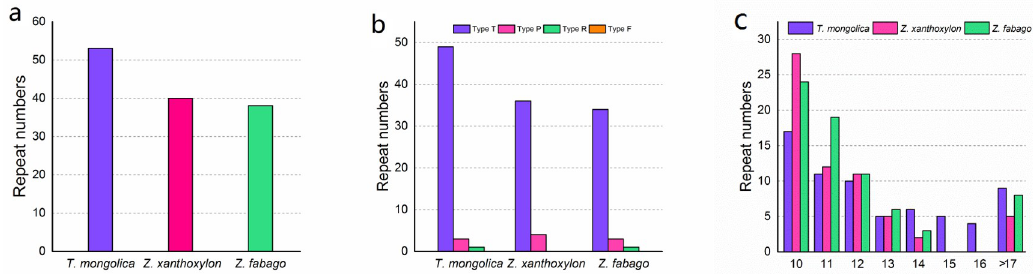
Fig 3. Long repeat sequences in chloroplast genomes of T . mongolica , Z . xanthoxylon , and Z . fabago . (a) Number of long repeats; (b) Number of different long repeats types; (c) Sequence length of long repeats.